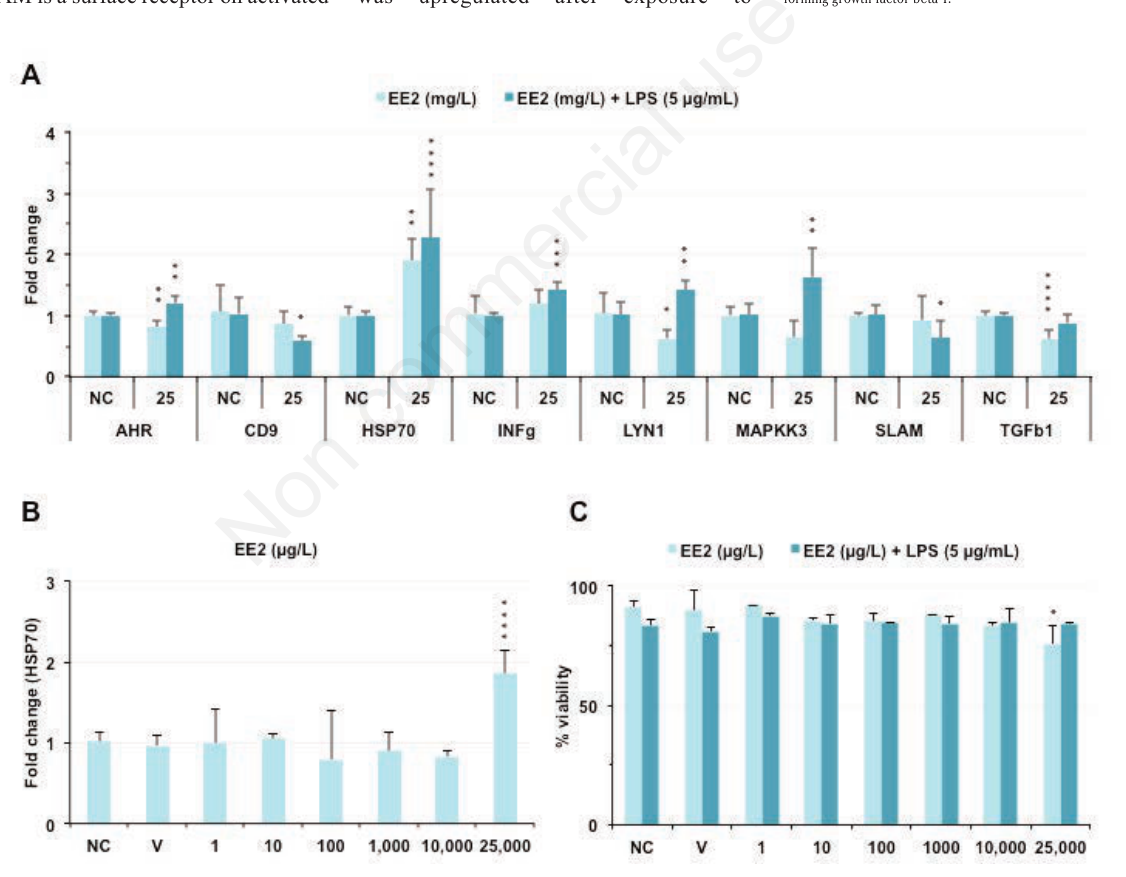
Figure 1. (A) Fold change in gene expression after 24 h exposure to 0 (NC) and 25 mg/L EE as measured by qPCR. A fold change of 2 1 indicated no change in comparison to the reference gene ß2M. (B) Dose-response gene expression changes of HSP70 mRNA after 24 h exposure to EE . (C) Viability of the 11B7501 B lymphoma cell line after 24 h exposure to EE and EE + LPS. Results are 2 2 2 expressed as Mean ± SD. (* p<0.05; ** p<0.01; *** p<0.001; **** p<0.0001). Abbreviations: EE =17 -ethinyl estradiol; 2 LPS=lipopolysaccharide; ßACT=beta actin; YWHAZ=14-3-3 protein zeta/delta; AHR=aryl hydrocarbon receptor; CD9=Cluster of dif- α ferentiation 9; HSP70=70 kDa heat shock protein; IFN =interferon gamma; LYN1=Lck/Yes novel tyrosine kinase; MAPKK3=mitogen- activated protein kinase kinase; SLAM=signaling lymphocytic activation molecule; TGFß1=transforming growth factor beta 1. γ